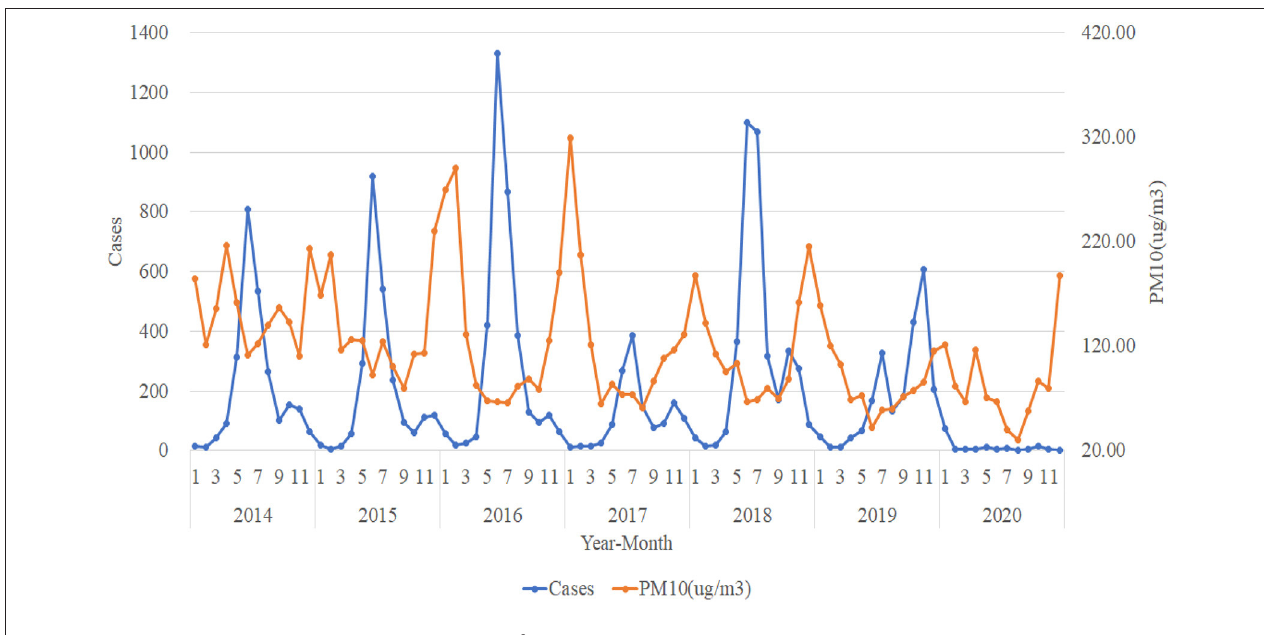
FIGURE 6 | Trends in the number of HFMD cases and PM 10 (ug/m 3 ).